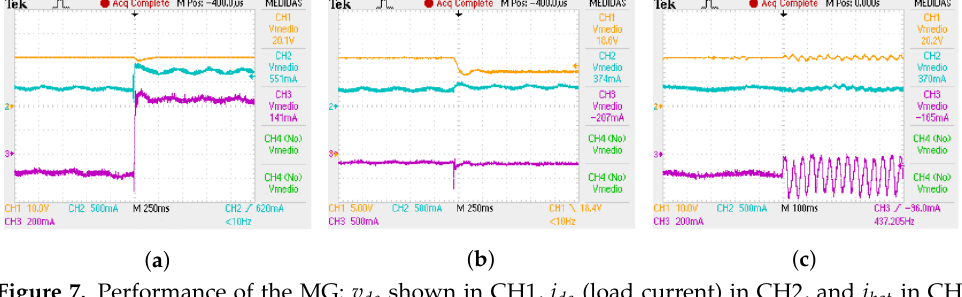
Figure 7. Performance of the MG: v dc shown in CH1, i dc (load current) in CH2, and i bat in CH3. ( a ) Change in CPL and fixed reference of the DC-link voltage. ( b ) Change in the reference of the DC-link voltage and fixed CPL value. ( c ) Change of the controller (IDA-PBC to PI) and fixed reference of the DC-link voltage and CPL